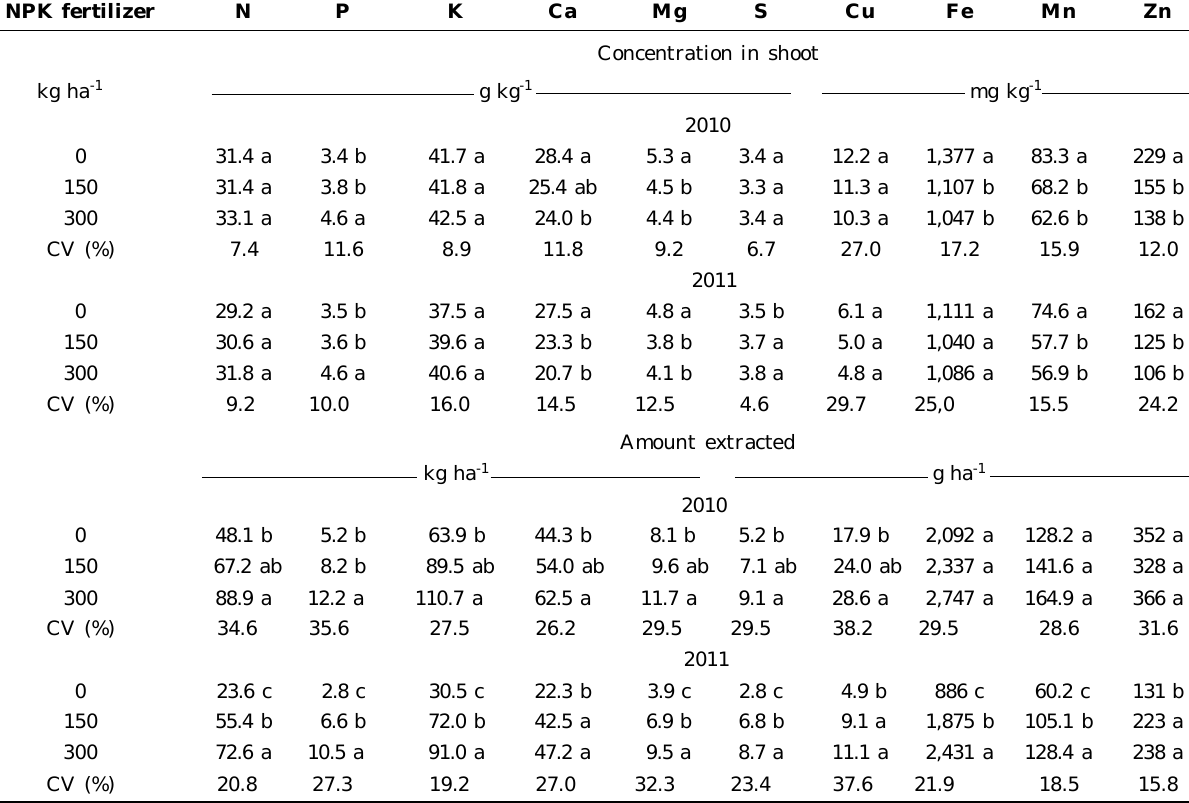
Table 2. Nutrient concentration and extraction in shoots of crambe treated with different rates of